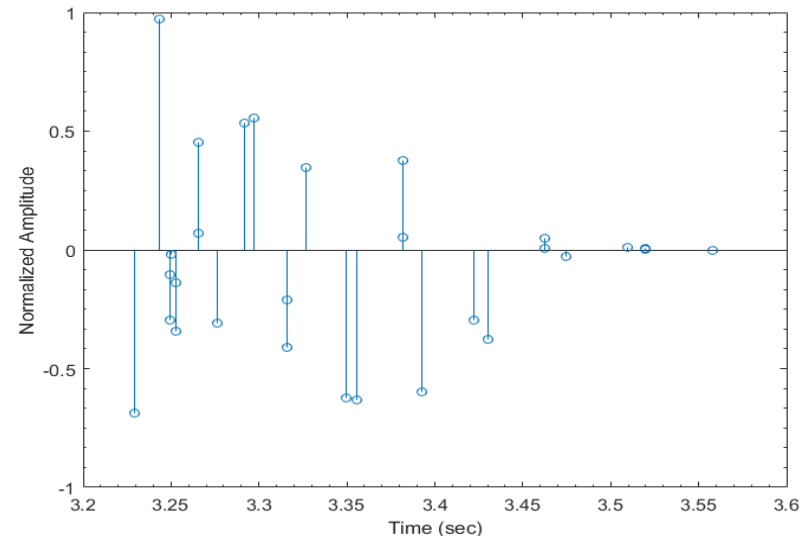
Figure 8. Simulation result of the channel impulse response.